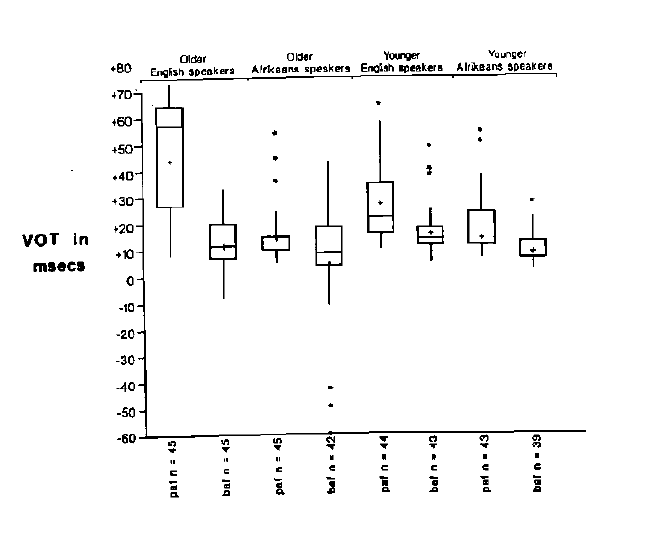
Figure 1 Summary box plots showing VOT values for the /paf/-/baf/ cognate pair in the four groups of subjects. A few extreme prevoicing scores have been omitted in older Afrikaans speakers.